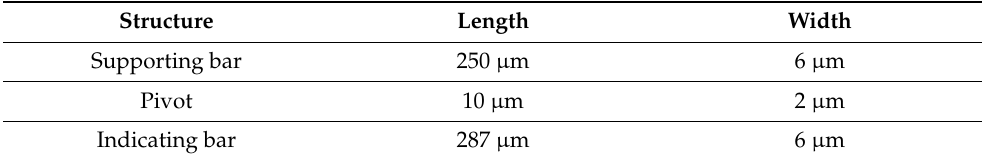
Figure 4. Picture of released strain gauge taken at the optical microscope. The geometrical parameters of the strain gauge are reported in Table 2. Table 2. Geometrical parameters of the strain gauge.